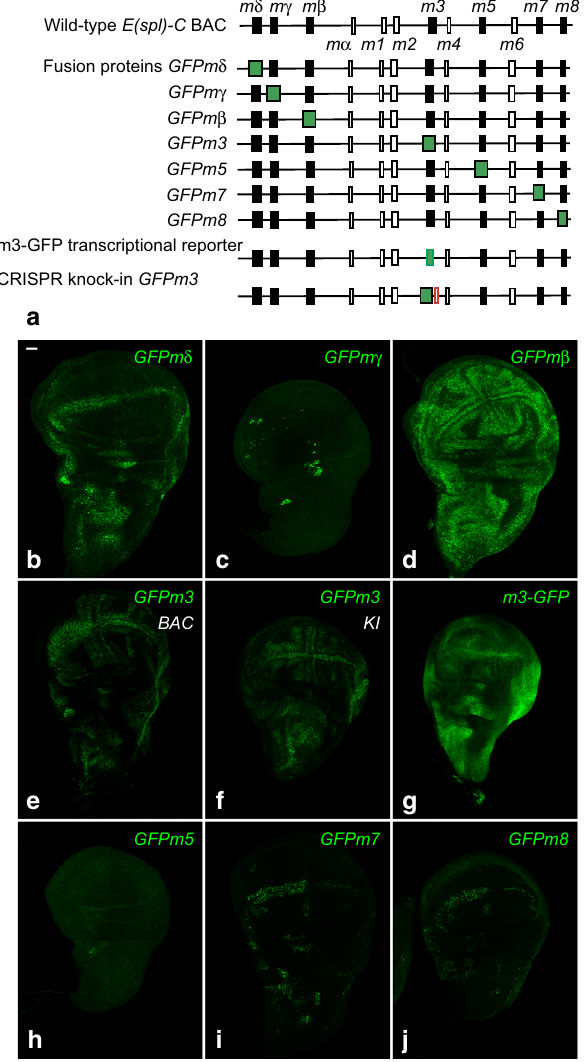
Fig. 3 a complete set of E(spl)-HLH reporters. a Genomic structure of the E (spl)-C BAC 59 . The seven E(spl)-HLH genes are shown in black, other genes appear as open boxes. The complete series of BAC transgenes encoding GFP-tagged fusion proteins, as well as the BAC transgene encoding a transcriptional reporter for the m3 gene, m3-GFP , are diagrammatically shown. A CRISPR knock-in locus with GFP-tagged m3 and a FRT site 3 ’ to the m3 gene is also shown. b – j Expression pattern of these E(spl)-HLH reporters (GFP, green) in third instar wing imaginal discs. Both the GFPm3 BAC transgene ( e ) and CRISPR knock-in line ( f ) are shown. Scale bar is 15 μ m ( b : b – j of Notch to pattern the proneural stripes, at least in the m β m3 double mutant.